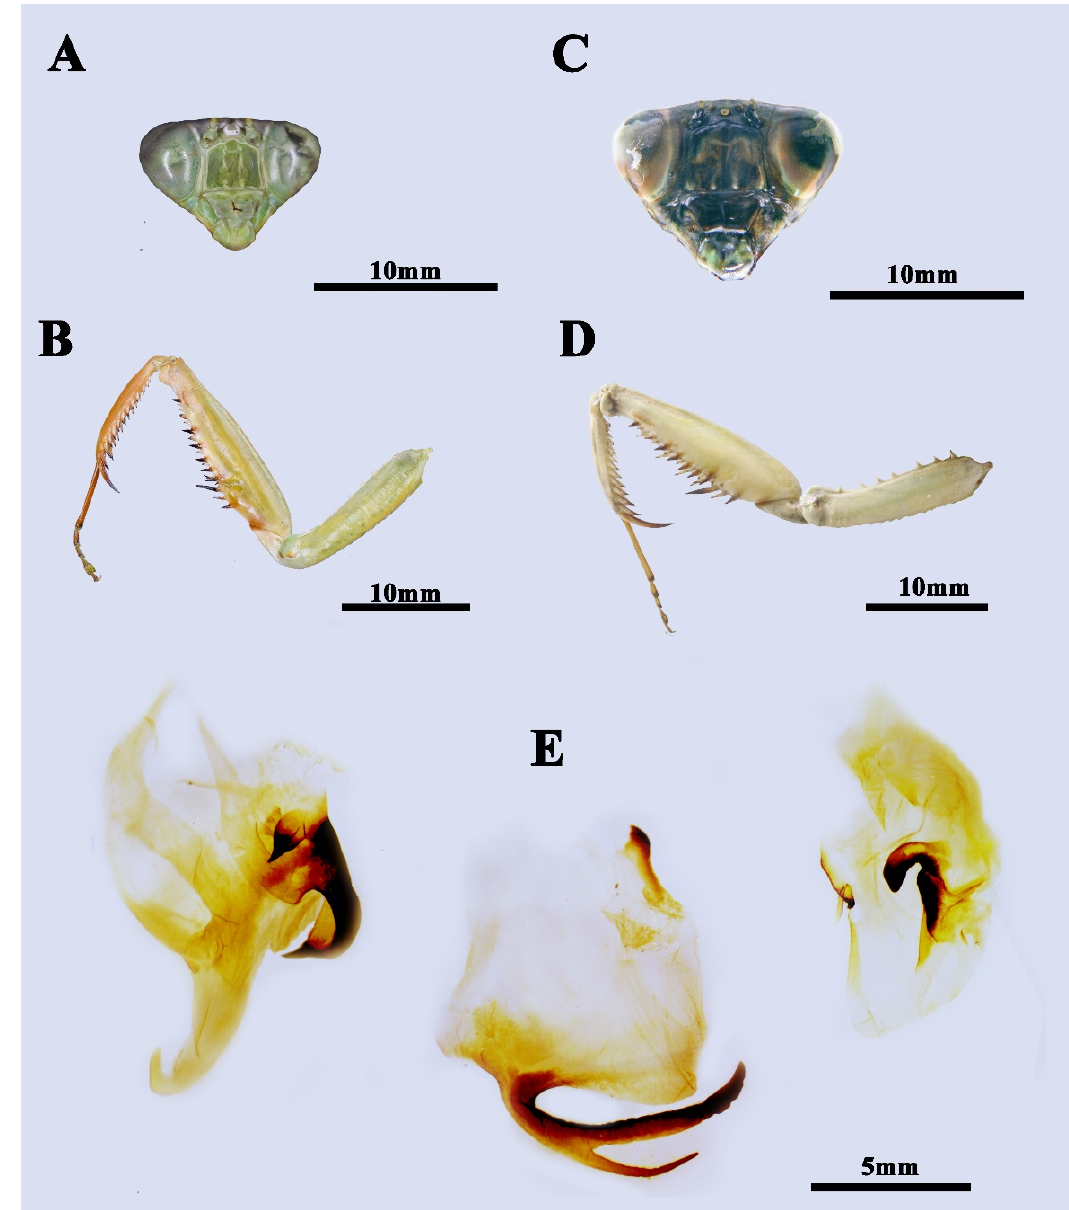
Figure 3. The anatomical structures of Rhombodera hyalina sp. nov. ( A , B ) Holotype, male. ( A ) Frontal view of the head. ( B ) Ventral view of forelegs. ( C , D ) Paratype1, female. ( C ) Frontal view of the head. ( D ) Ventral view of forelegs. ( E ) Male genitalia. Left: left phallomere; the middle: ventral phallomere; Right phallomere.